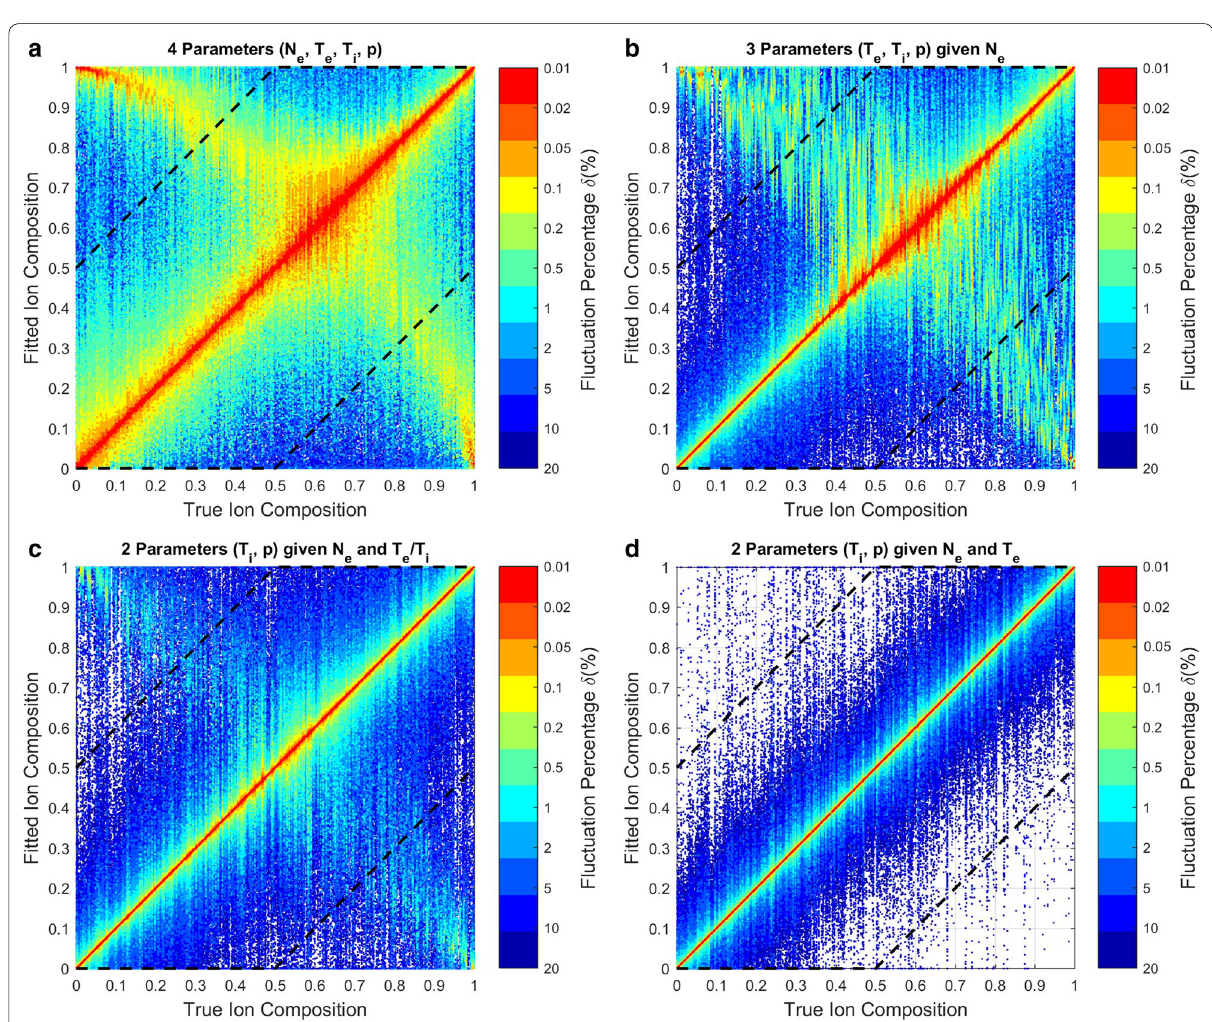
Fig. 3 Scatter plot of estimated and input values of ion composition, obtained from the Monte Carlo analysis of different combinations of parameters known a priori from the plasma line using the PSO algorithm: a without a priori information, b given N e , c given N e and T e / T i , and d given N e and T e . Each color represents results obtained by simulations with a particular signal fluctuation percentage ( δ( % ) ). Simulations were done with the full ion composition search range. Black dashed lines represent the maximum and minimum values of the confined ion composition search range of Wu et al.